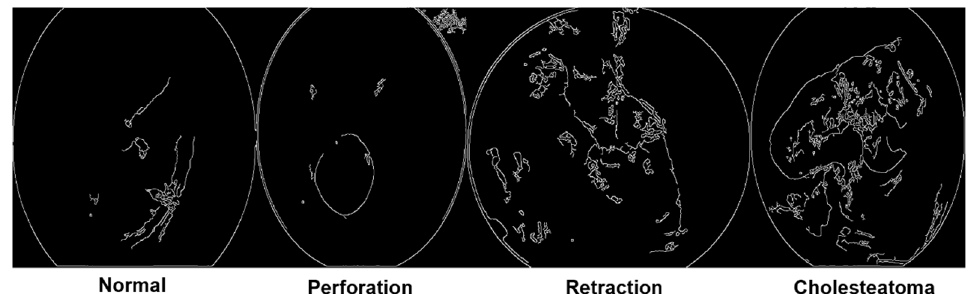
Figure 6 . Image after applying Canny edge detection.